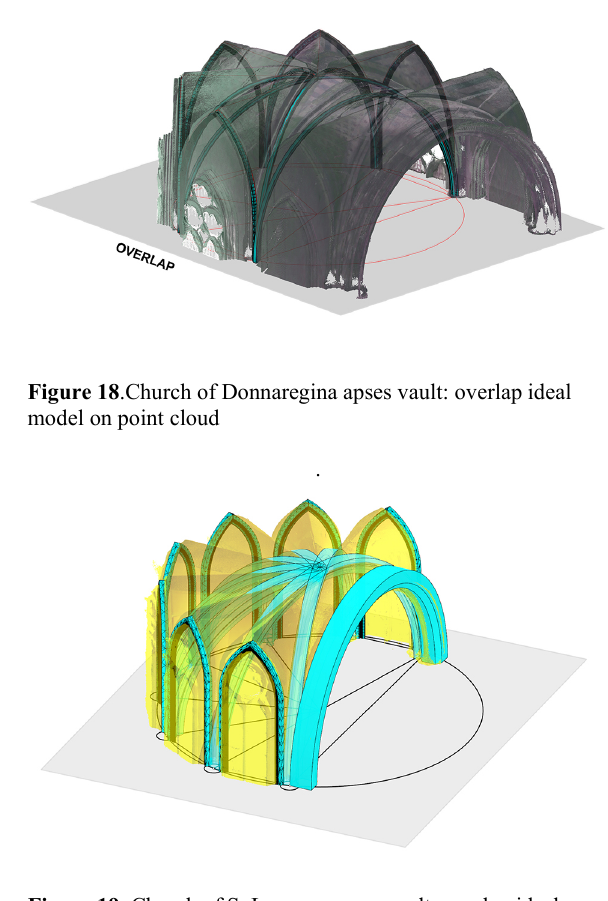
Figure 19 . Church of S. Lorenzo apses vault: overlap ideal model on point